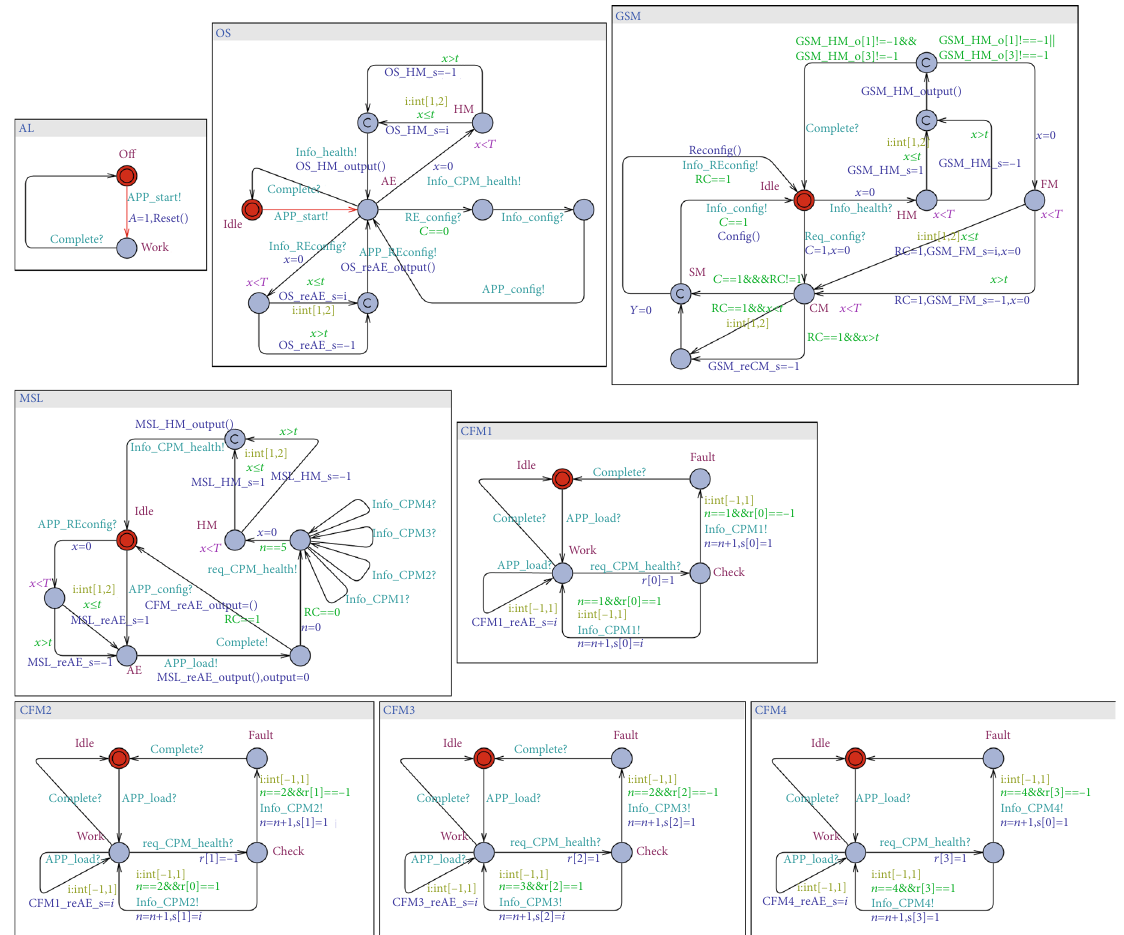
Figure 7 : Timed automaton network model of IMA recon fi